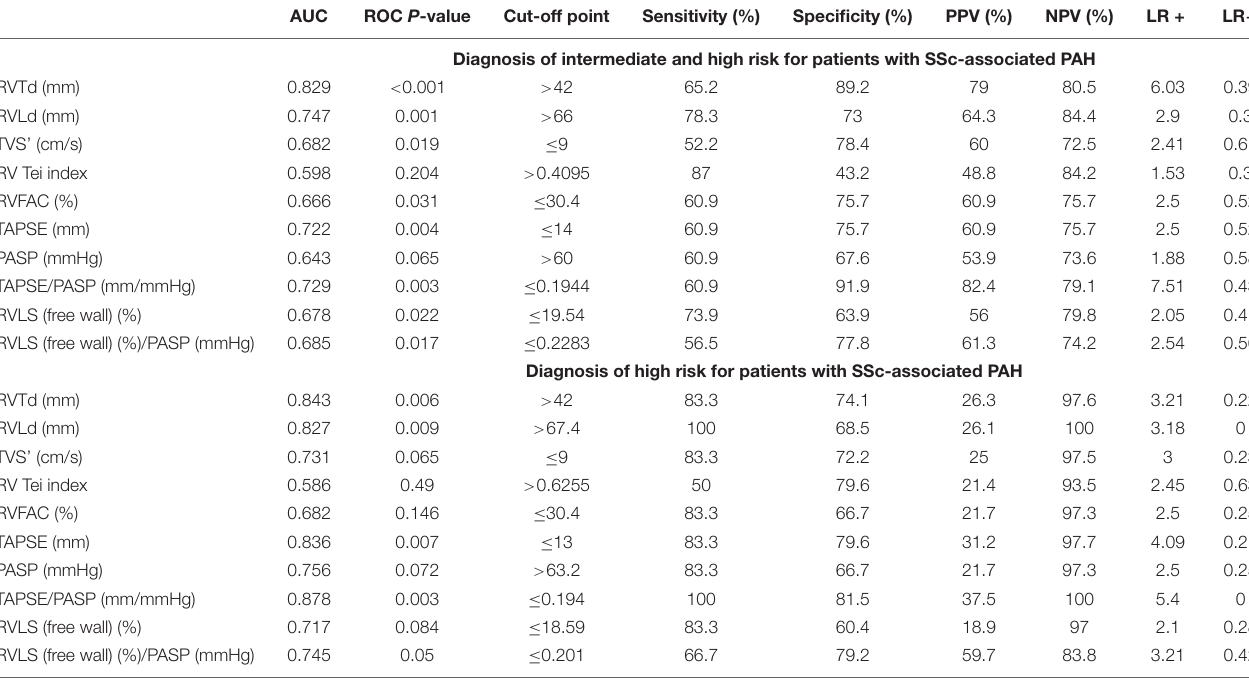
FIGURE 2 | Receiver operating characteristic curve showed the optimal cut-off for RV-PA coupling to determine SSc-PAH patients with stratification of (A) intermediate and high risk and (B) high risk. ROC, receiver operating characteristic; RV-PA, right ventricle to pulmonary artery. TABLE 2 | Receiver operating characteristic analysis and diagnostic accuracy of significant echocardiographic parameters in the prediction of risk stratification for patients with SSc-associated PAH. AUC ROC P -value Cut-off